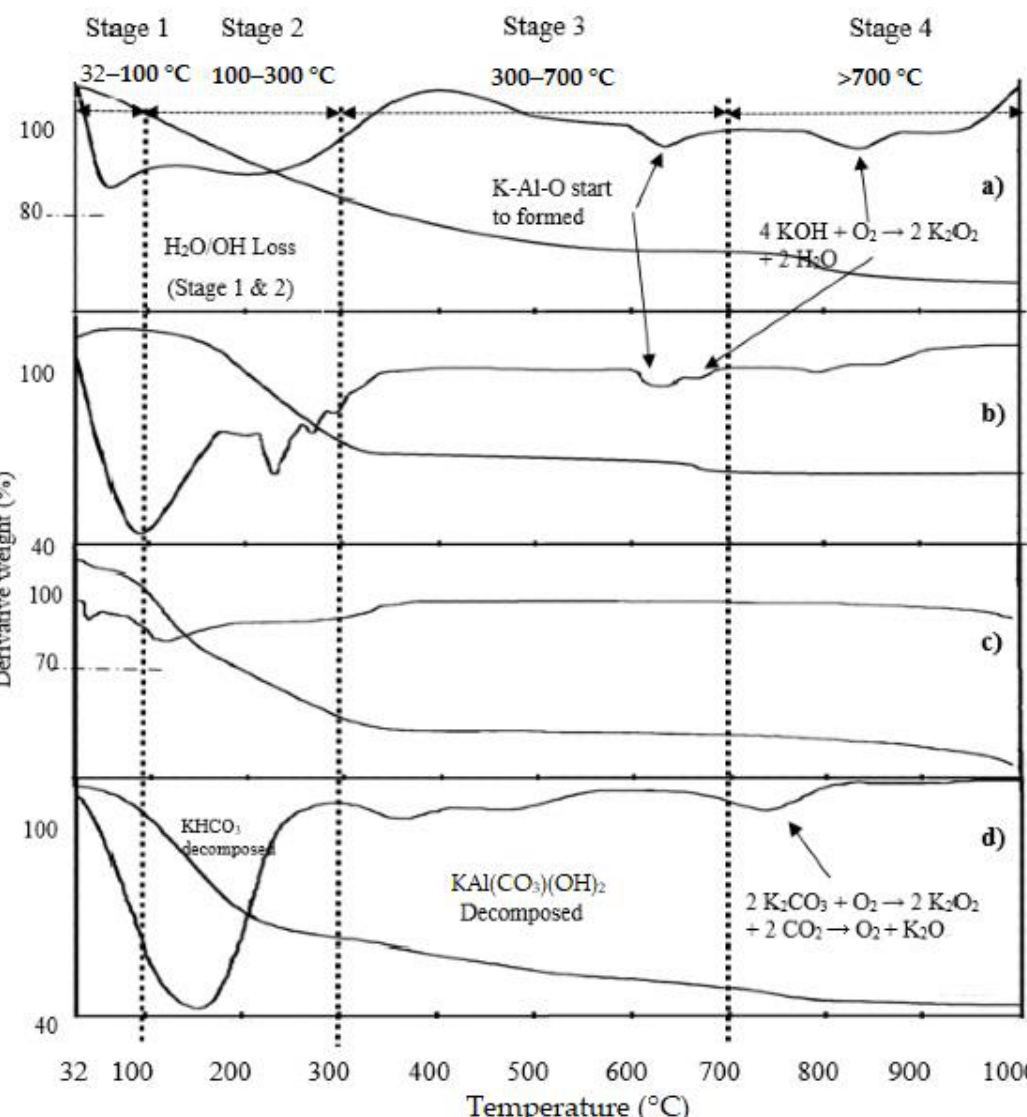
Figure 1. TGA thermogram of ( a ) powder KOH/Al 2 O 3 , ( b ) beads KOH/Al 2 O 3 , ( c ) powder K 2 CO 3 /Al 2 O 3 , and ( d ) beads K 2 CO 3 /Al 2 O 3